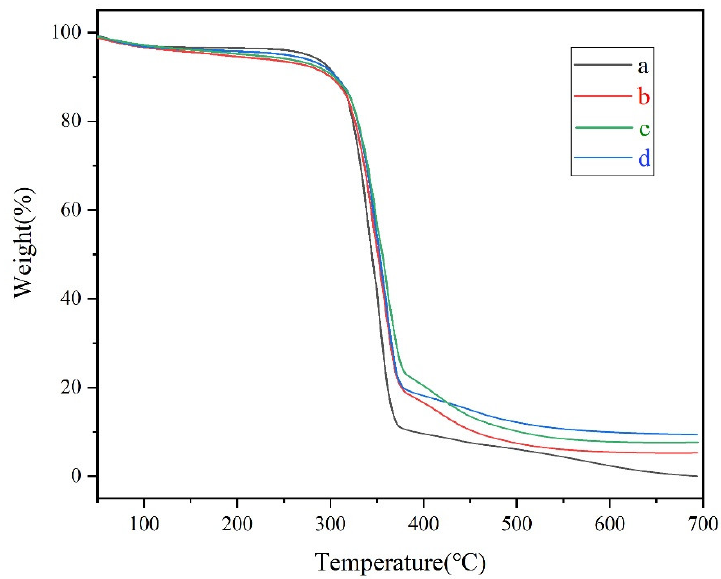
Figure 9. TGA cures of samples a, b, c, d: (a) Original paper; (b) PMETAC-PTSPM coated paper; (c) SiO 2 -NH 2 coated paper; (d) Modified paper coated with PMETAC-PTSPM/SiO 2 -NH 2 . Samples were heated to 700 °C in air atmosphere at a ramp rate of 10 °C/min −1 .